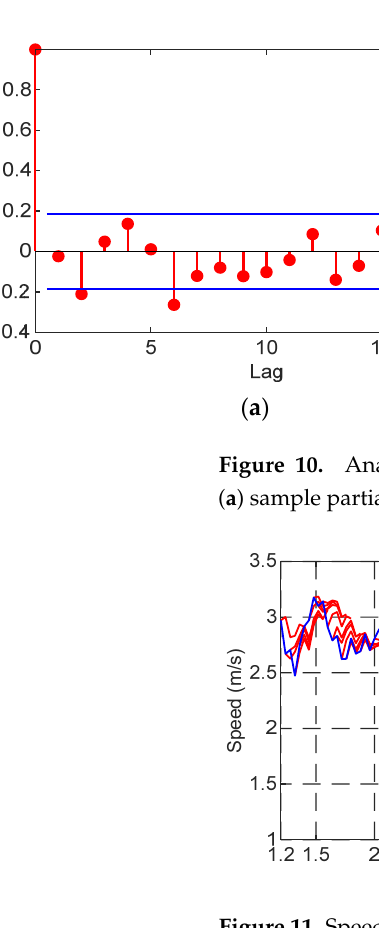
Figure 11. Speed-prediction results based on ARIMA model.